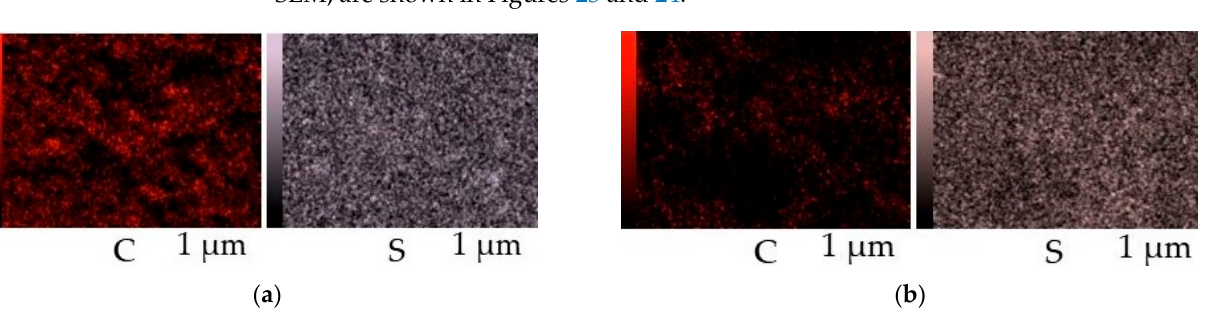
Figure 23. ( a ) Distribution of sulfur (S) and carbon (C) in the catalyst after deactivation type 1 (scanning electron microscopy (SEM)). ( b ) Distribution of active metals, sulfur and carbon, in the catalyst after deactivation type 2 (SEM).